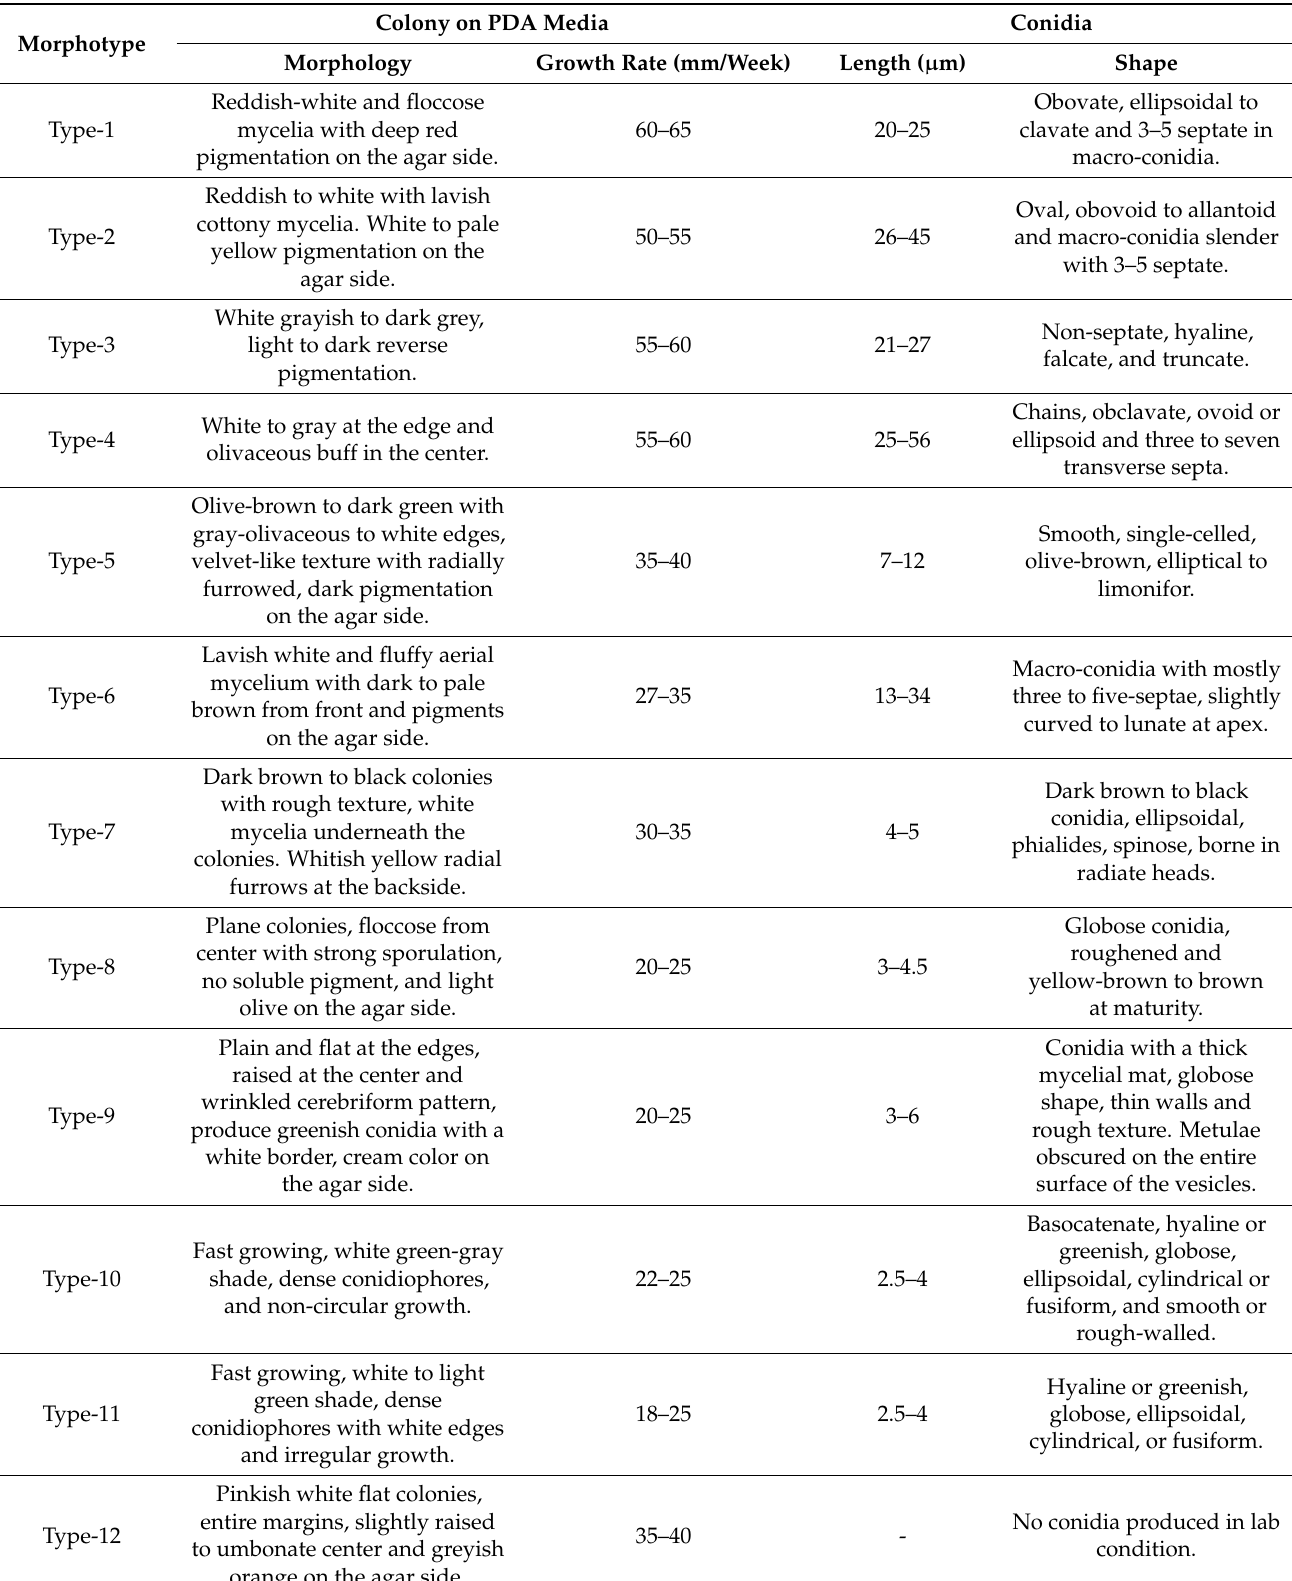
Table 2. Morphological characteristics of 12 morphotypes of the isolated fungal species based on colony and conidial